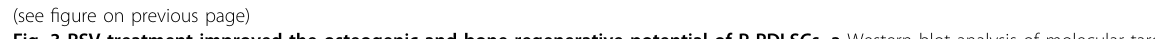
Fig. 3 RSV treatment improved the osteogenic and bone regenerative potential of P-PDLSCs. a Western blot analysis of molecular targets demonstrated inhibition of the NF κ B pathway and stimulation of the AMPK pathway by RSV in P-PDLSC aggregates. b Osteogenesis of PDLSC aggregates demonstrated by ALP (top) and alizarin red staining (bottom). Bars: 5 mm (top) and 50 μ m (bottom). c , d RSV treatment improved the ALP activity ( c ) and mineralized capability ( d ) of P-PDLSC aggregates. e qRT-PCR analysis of the osteogenic marker genes Alp , Runx2 , Ocn , and Col1 in PDLSC aggregates after osteogenic induction. The data showed that RSV promoted the osteogenic potential of P-PDLSC aggregates. f – h Histological analysis of ectopic tissue regeneration of PDLSC aggregates in nude mice by HE and Masson ’ s trichrome staining ( f ) showed that P-PDLSC aggregates regenerated less bone (denoted by B) ( g ) and formed less collagen bone matrix (denoted by C) ( h ), which could be promoted by RSV treatment. Calcined bovine bone (CBB) was used as the scaffold. RSV was applied at 10 nM throughout the in vitro treatments. Bars: 50 μ m. n = 3 per group ( a ) and n = 6 per group ( b – h ). The data represent the mean ± SD. * P < 0.05